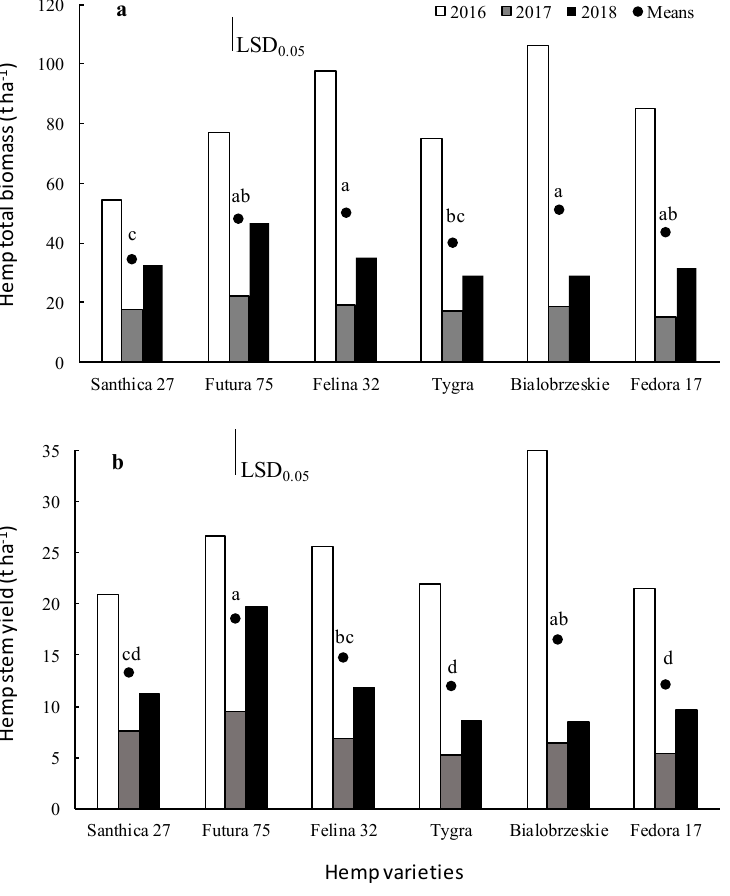
Figure 3. Total ( a ) and stem ( b ) biomass of six industrial hemp varieties. For the year × variety interaction, columns with height differences lower than the LSD height did not significantly differ according to the Fisher’s Protected Least Significant Difference (LSD) test at p = 0.05. For the variety effect, points with the same letter did not significantly differ according to the Fisher’s Protected Least Significant Difference test at p =